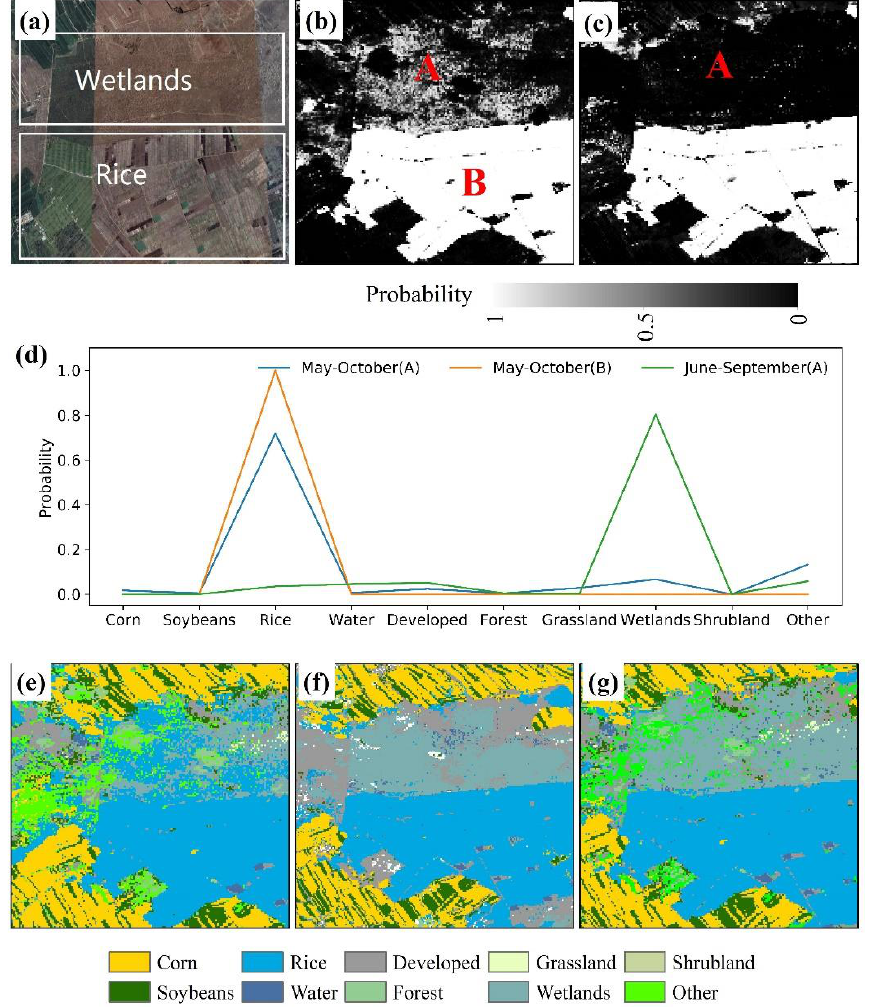
Figure 6. Correction of rice classification combined with phenological sequence sequences of different lengths. ( a ) Google Earth image on 4 September 2019, including wetlands and rice; ( b ) May–October rice category probability values throughout the growth period, where A and B are the two locations representing wetlands and rice, respectively; ( c ) June–September. Rice category probability; ( d ) comparison of the probability values of each category in the two positions A and B; ( e ) May-October classification results of the whole growing period; ( f ) June–September classification results; ( g ) merge the length-corrected results of the two-time series.